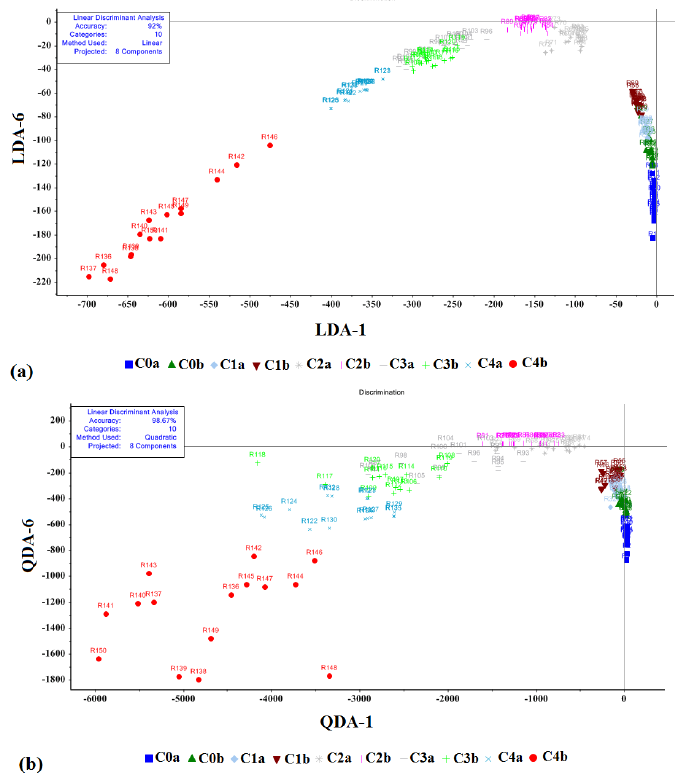
Figure 3. Classification of cucumber fruits. E-nose data using ( a ) a linear discriminant analysis (LDA) and ( b ) quadratic discriminant analysis (QDA) statistical methods. Graph legend symbol combinations (for individual fruit harvests): C = cucumber fruit harvest; Numbers indicate urea fer- tilizer equivalent application rates: 0 = 0 kg/h, 1 = 100 kg/h, 2 = 200 kg/h, 3 = 300 kg/h, 4 = 400 kg/h; Small letters indicate sequential sub-harvests: a = first sub-harvest (4 months after planting seeds), b = second sub-harvest (5 months after planting seeds). A visual assessment of the data point (scatterplot) distribution patterns for the LDA and QDA models indicates very similar and comparable two-dimensional models that both provide effective and strong representations of the ten sub-harvests (a and b) for the five urea treatments (C0 to C4, indicating increasing rates of 0–400-kg/h urea-applied fer- tilizer equivalents) from left to right on each corresponding graph (Figure 3a,b). Data clus- ters by treatment tended to become tighter and more closely clustered as the urea fertilizer rate increased. The polynomial (QDA) model provided a better curve fit for the data than the linear (LDA) model with a higher correlation, indicating a better model for estimating